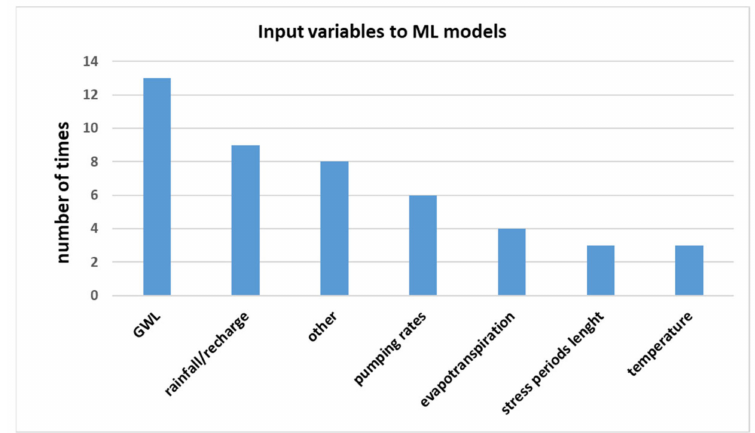
Figure 4. Input variables employed for the machine learning